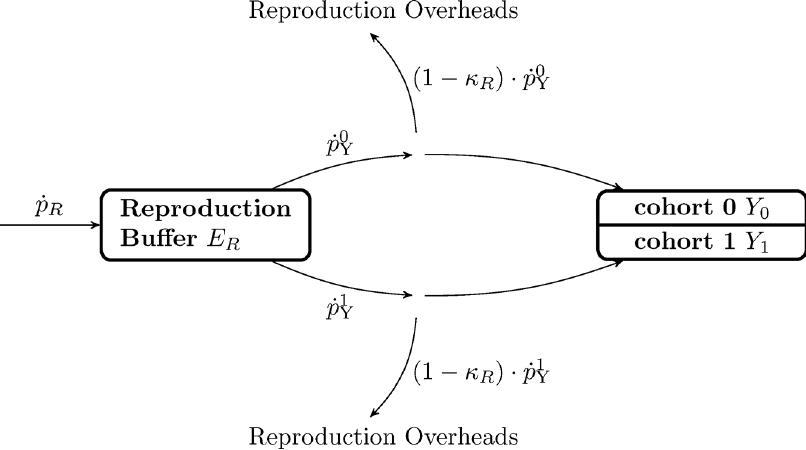
Fig 2. Schematic representation of the reproduction buffer handling rules for Odontaster validus . Arrows represent energy fluxes (J d -1 ). After paying for maturity costs p _ E R that is continuously being mobilized to develop the gonads. The gonads contain two different cohorts of oocytes, each one receiving energy at a rate given by _ p _ n Y , however cohort 1 is 365 days older than cohort 0 and _ p _ n Y depends on t (age). κ R is the reproduction ef fi ciency and represent the energy dissipated as the buffer is transformed into